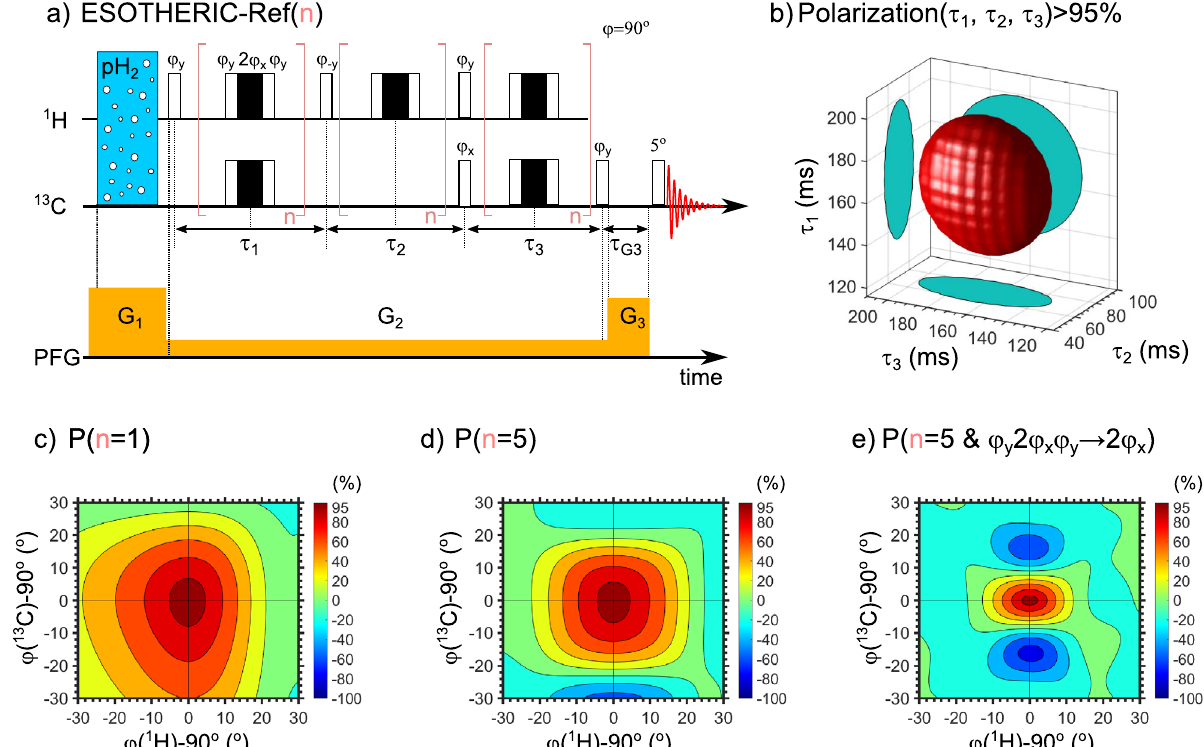
o Figure 3. ESOTHERIC-Ref SOT applied to 1- 13 C-EP- d6 : sequence itself ( a ), ( ϕ = 90 ), simulated polarization isosurface as a function of τ 1 , τ 2 and τ 3 for P = 95% ( b ), and simulated effect of flipping angle deviation from the nominal value on P for n = 1 ( c ), n = 5 ( d ) with composite refocusing pulses ( ϕ y 2 ϕ x ϕ y ) and n = 5 with only one refocusing pulse ( ϕ y 2 ϕ x ϕ y → 2 ϕ x ). The polarization of 99.7% 1- 13 C-EP- d6 was reached at τ 1 = τ 3 = 166 ms, τ 2 = 70 ms. The longest diameters of isosurface were 66 ms for τ 1 and τ 3 , and 28 ms for τ 2 . To compensate for diffusion in the inhomogeneous magnetic field, multiple refocusing blocks were required; here calculations neglect diffusion, and convection, and are carried out for homogeneous magnetic fields with ideal RF pulses. Note that a composite refocusing pulse was necessary to compensate for B 1 inhomogeneity and deviation of flipping angle from the nominal value (compare ( d ) and ( e )). Although it seems that n = 1 is superior to n = 5 cases, for a final justification one has to include the convection and diffusion in the inhomogeneous field in the simulations. The diameters of the 95% polarization threshold in ( c ), ( d ), and ( e ) were 10°, 8.6°, 4.5° for ϕ ( 1 H) and 14.9°, and 12.4°, 3.5° for ϕ ( 13 C). Note that we used ideal RF pulses, hence the gradients did not affect the spin dynamics. More examples are in